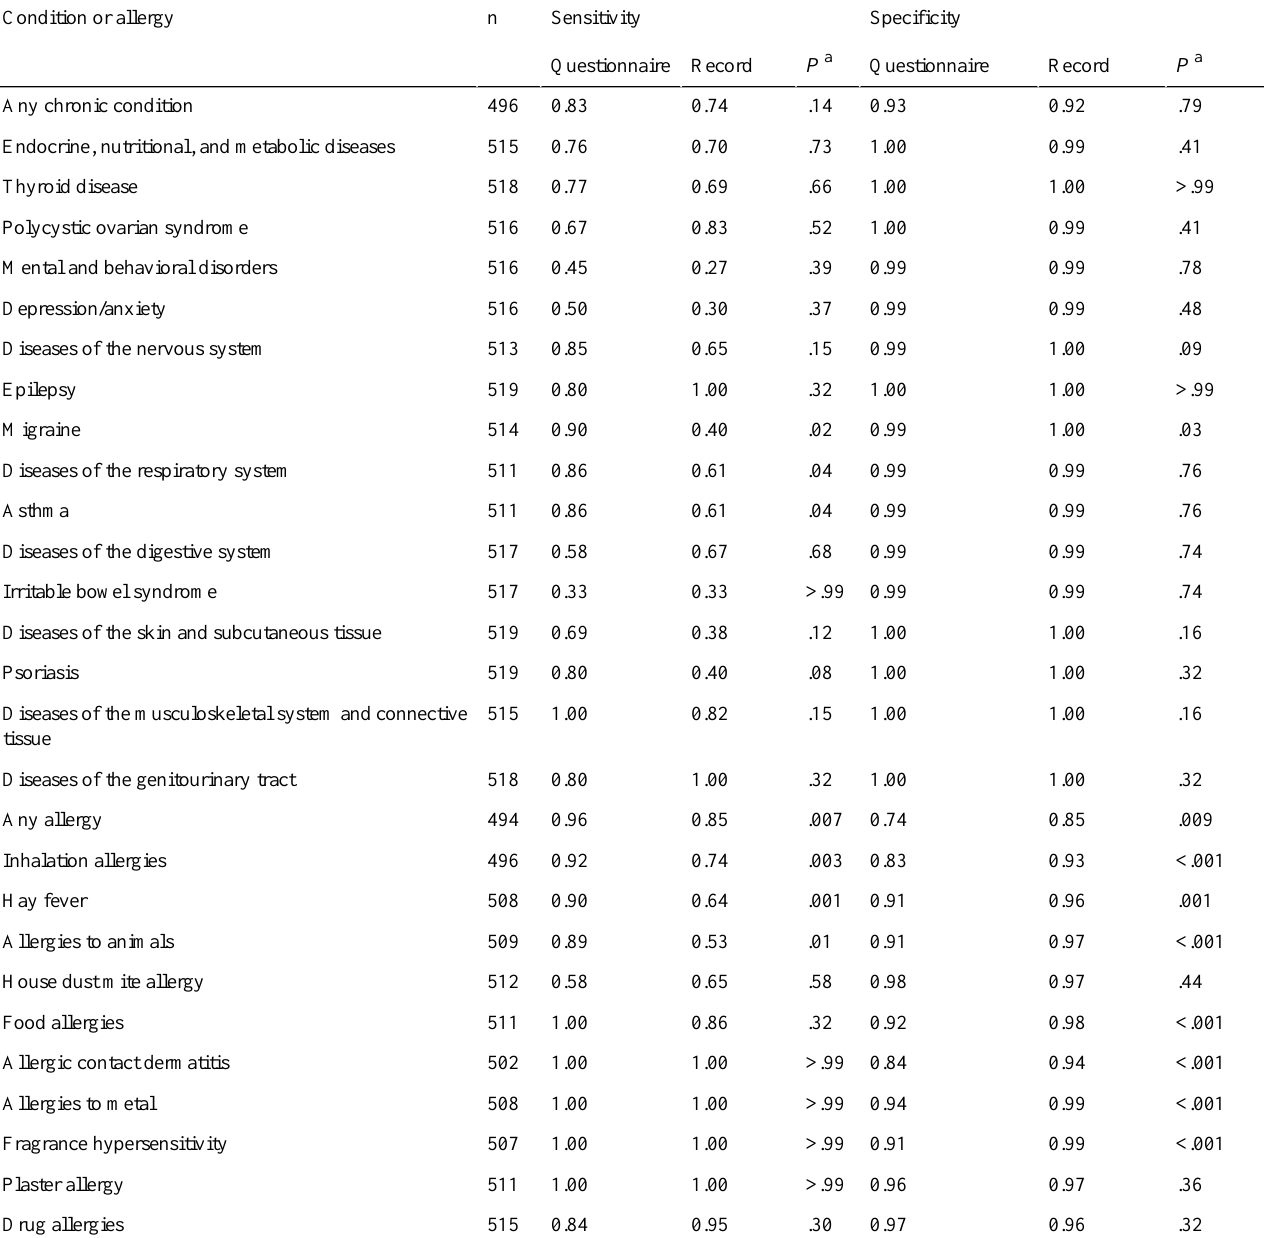
Table 4. Validity comparisons of chronic conditions and allergies among pregnant women: Web-based questionnaires and obstetric records compared to GP